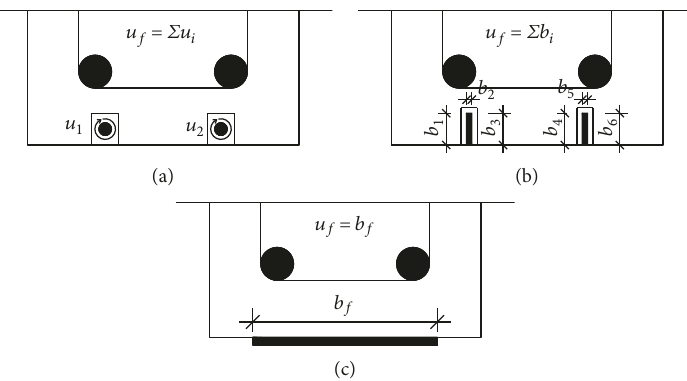
Figure 3: Bond perimeter of FRP reinforcement: (a) FRP rods; (b) FRP strips; (c) EBR.